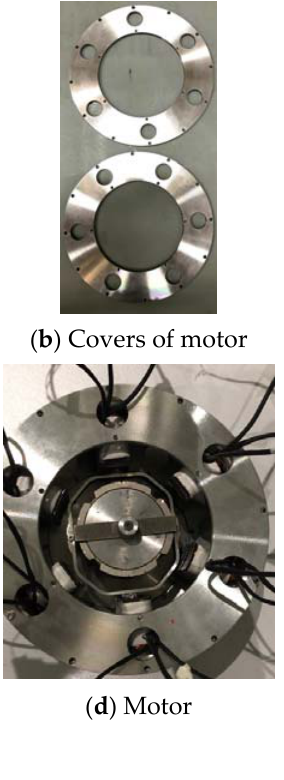
Figure 17. Experimental setup for the measurements of forces and torques. 5.2. Experimental Results of the Magnetic Flux Density in the Air Gap of the Motor at No ‐ Load Conditions Based on the results of the experimental studies and the simulation in the air gap, the magnetic flux density in the air gap of the motor at no ‐ load conditions is shown in Figure 18. Figure 18. Measured and simulation results of the magnetic flux density in the air gap of the motor at no ‐ load conditions. As can be seen from Figure 18, when the motor was at no ‐ load conditions, the meas ‐ ured maximum magnetic flux density distribution in the air gap was obtained to be 0.29 T based on the experimental studies. When the simulation and experimental results were examined, the average magnetic flux densities were obtained to be 0.237 T and 0.229 T in the air gap of the motor, respectively. When these results were compared, it was seen that the simulation results were as 97% accurate as the experimental results. 5.3. Experimental Results for Magnetic Flux Density in the Air Gap of the Motor at Load Conditions